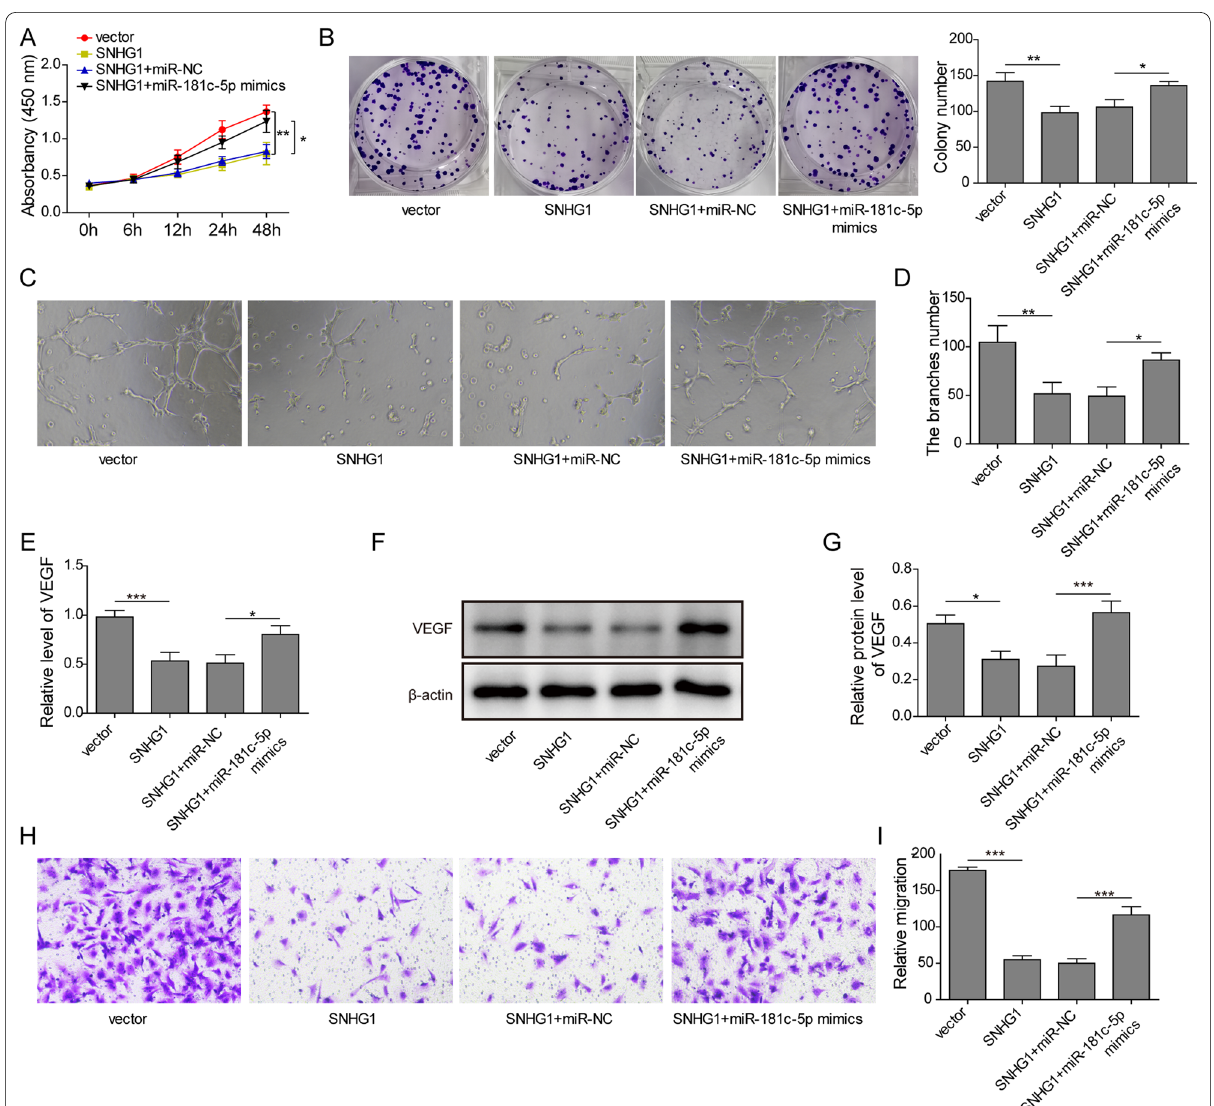
Fig. 5 Overexpression of lncRNA SNHG1 inhibited tube formation of BM‑EPCs via targeting miR‑181c‑5p. The BM‑EPCs were transfected with vector‑NC, SNHG1 vector, SNHG1 vector with miR‑NC, or SNHG1 vector with miR‑181c‑5p mimics for 48 h. A and B The cell proliferation and colony were detected by CCK‑8 assay and colony formation assay. C After cultured with Matrigel for 6 h, the images of tubular structures of transfected BM‑EPCs. D The tube lengths in every group. E The mRNA expression level of VEGF in BM‑EPCs was detected by qPCR. D and E The protein expression level of VEGF was measured through western blot. F and G Cell migration was detected using Transwell assay. * P < 0.05, ** P < 0.01, *** P < 0.001